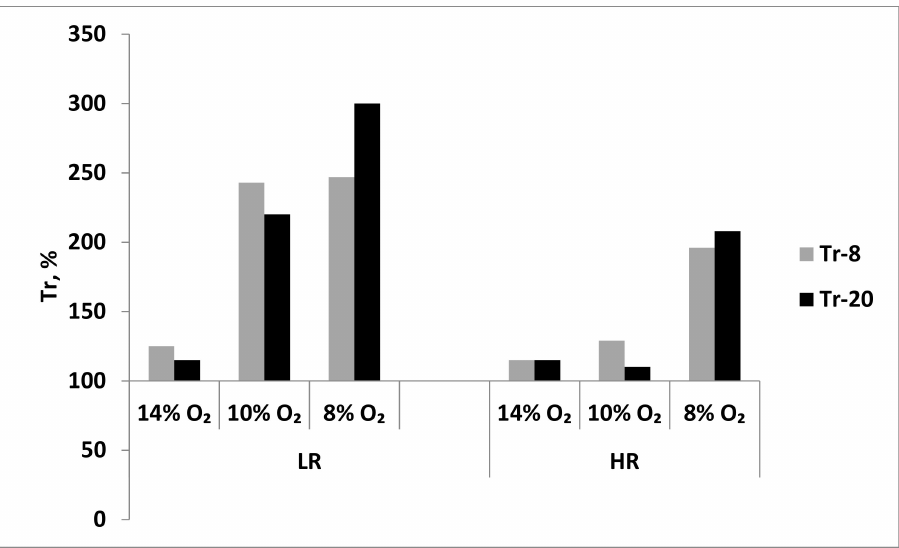
Figure 8. Effect of long-term adaptation (8 and 20 sessions) to various hypoxic regimens on Tr (resistance index, time to development of pathological breathing at a subcritical altitude in